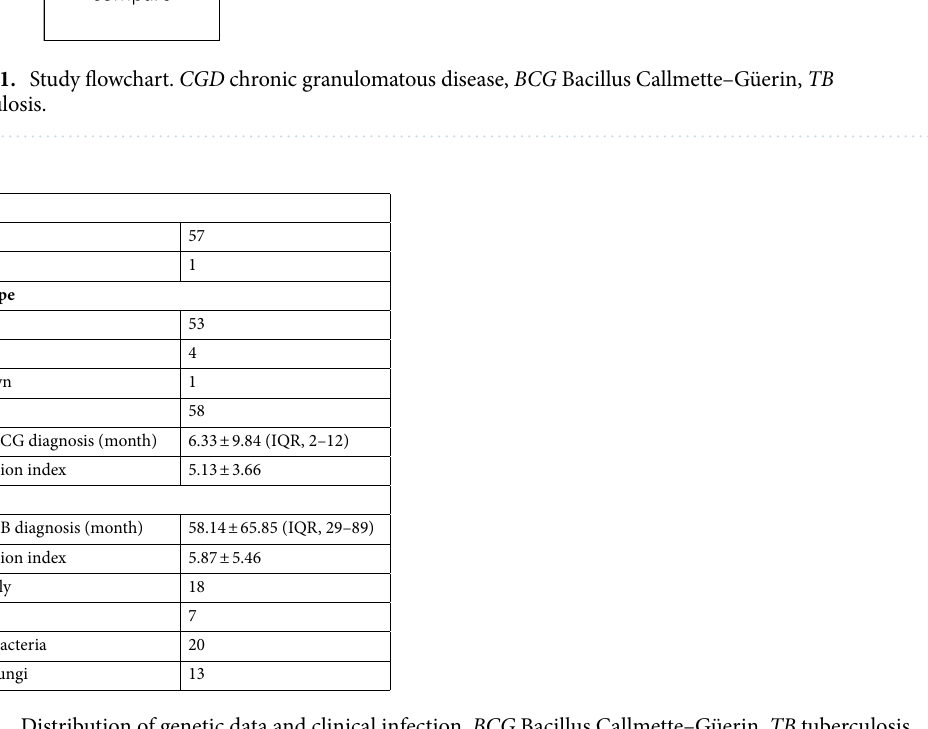
Table 1. Distribution of genetic data and clinical infection. BCG Bacillus Callmette–Güerin, TB